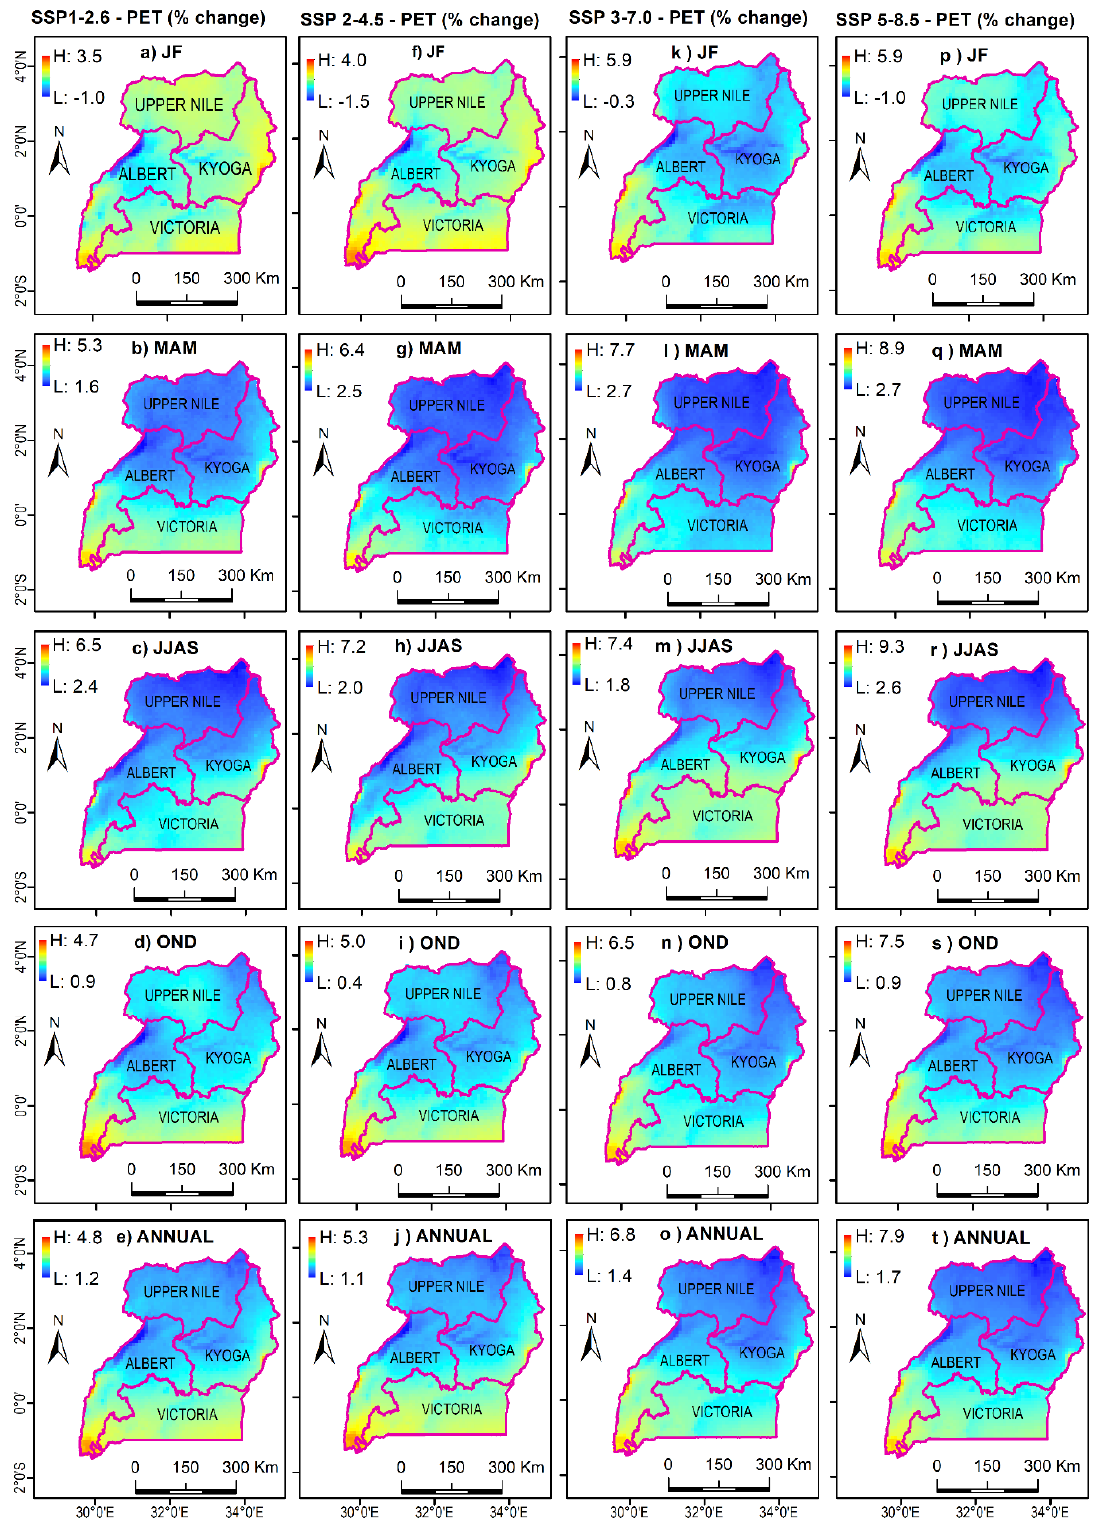
Figure A4. Percentage change in PET over the period 2041 – 2060.